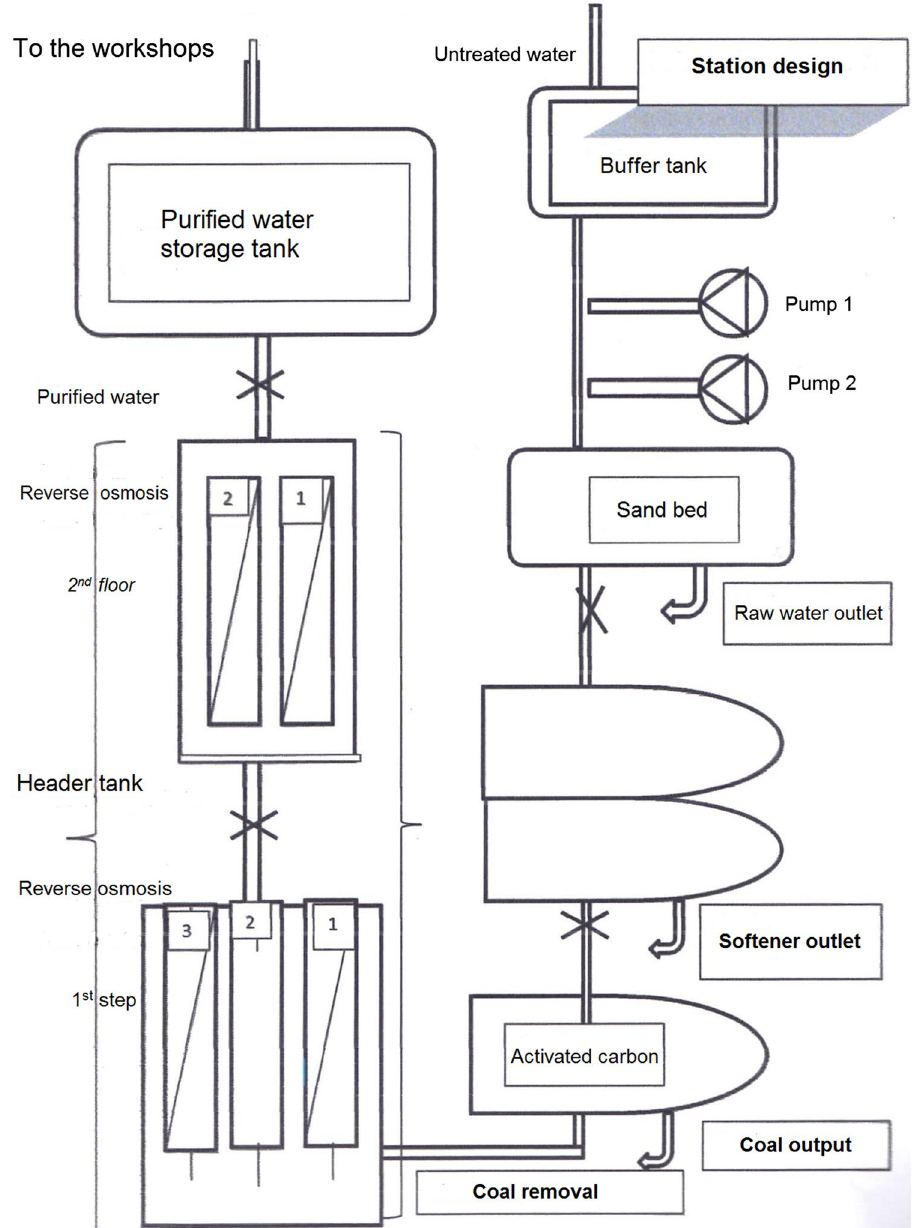
Fig. 3 The water treatment